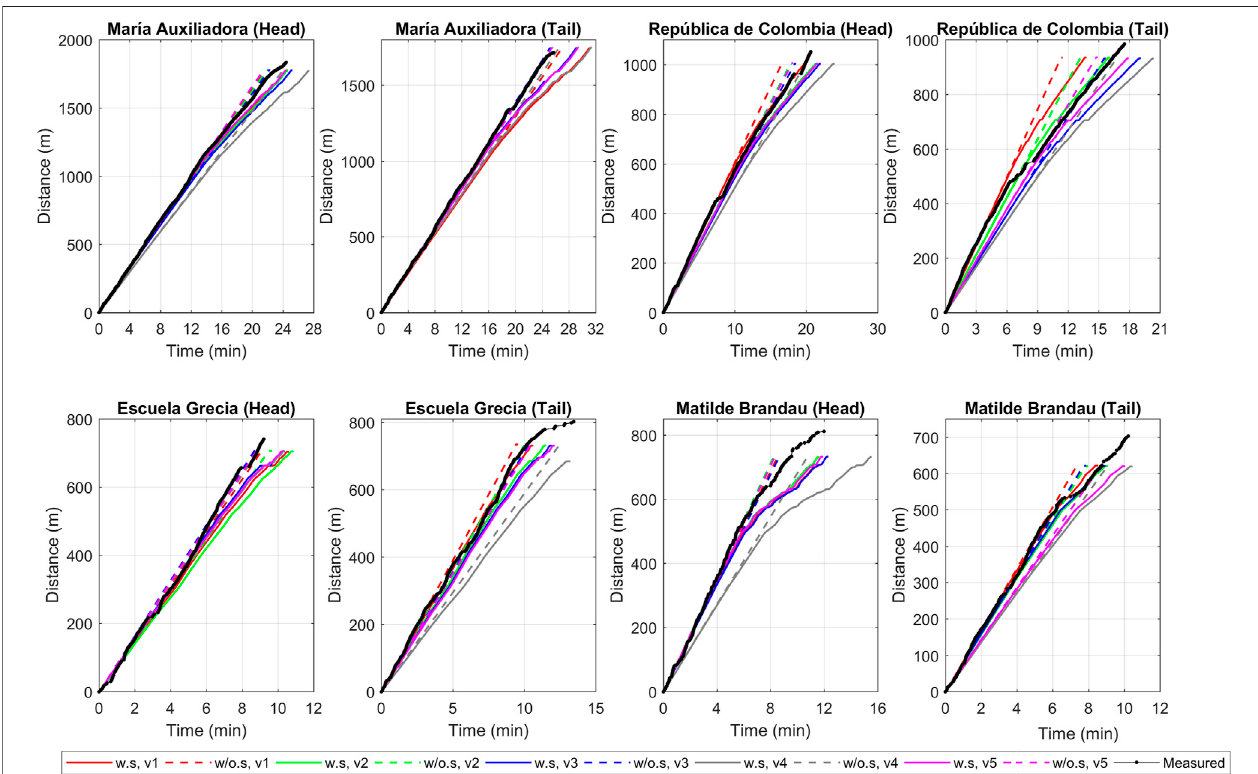
FIGURE 4 | Comparison between the surveyed and modelled evacuation speeds of the four examined schools.